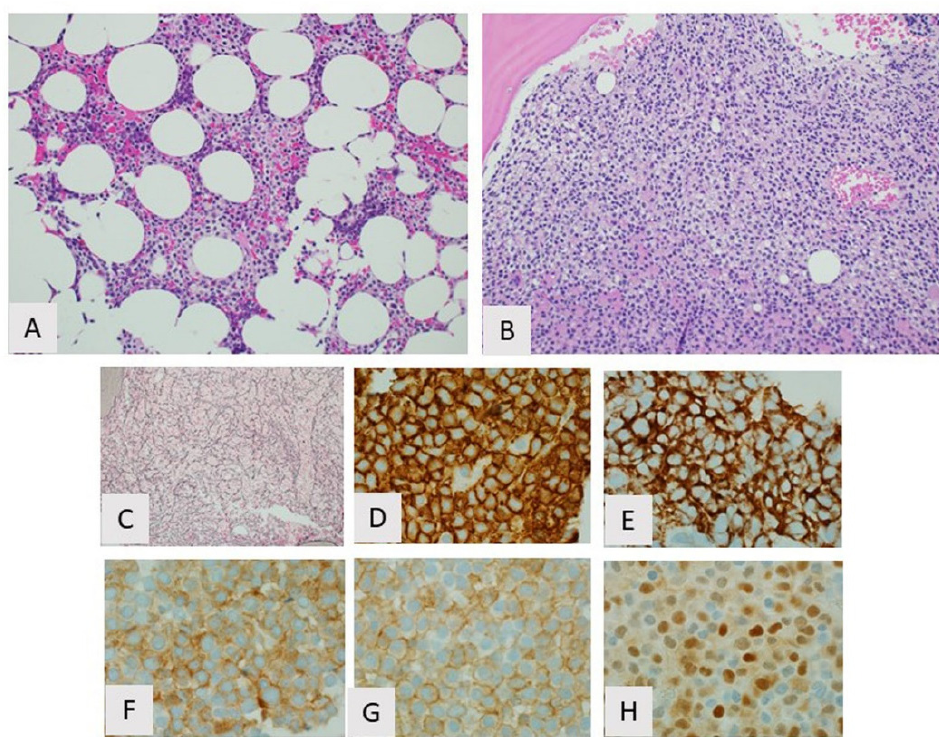
Figure 2. Hairy cell leukemia, bone marrow. ( A ) Partial involvement showing typical interstitial growth pattern with “fried egg” appearance, H&E, 20×; ( B ) diffuse involvement with sheet-like growth pattern H&E, 20×; ( C ) increased reticulin fibrosis, reticulin stain, 20×. By immunohistochem- istry the cells are positive for ( D ) CD20, ( E ) CD103 ( F ) CD25, ( G ) annexin A1, and ( H ) cyclin D1.